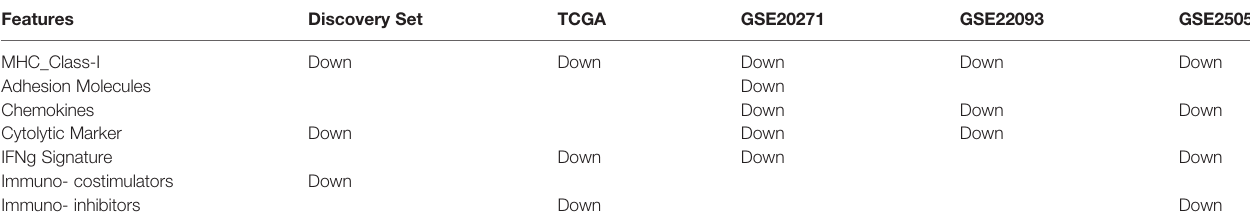
TABLE 4 | Comparing the resistant group and the sensitive group, the immune-related characteristics are downregulated.